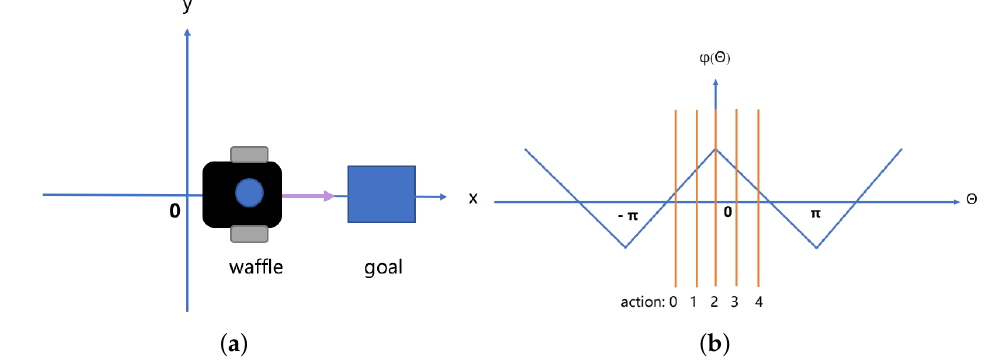
Figure 6. This is a graph of the function between angle and action. ( a ) Describes at this point θ = 0, indicating that the robot is moving in the direction of the target. ( b ) Denotes the function of theta generated by the robot action corresponding to φ ( θ )